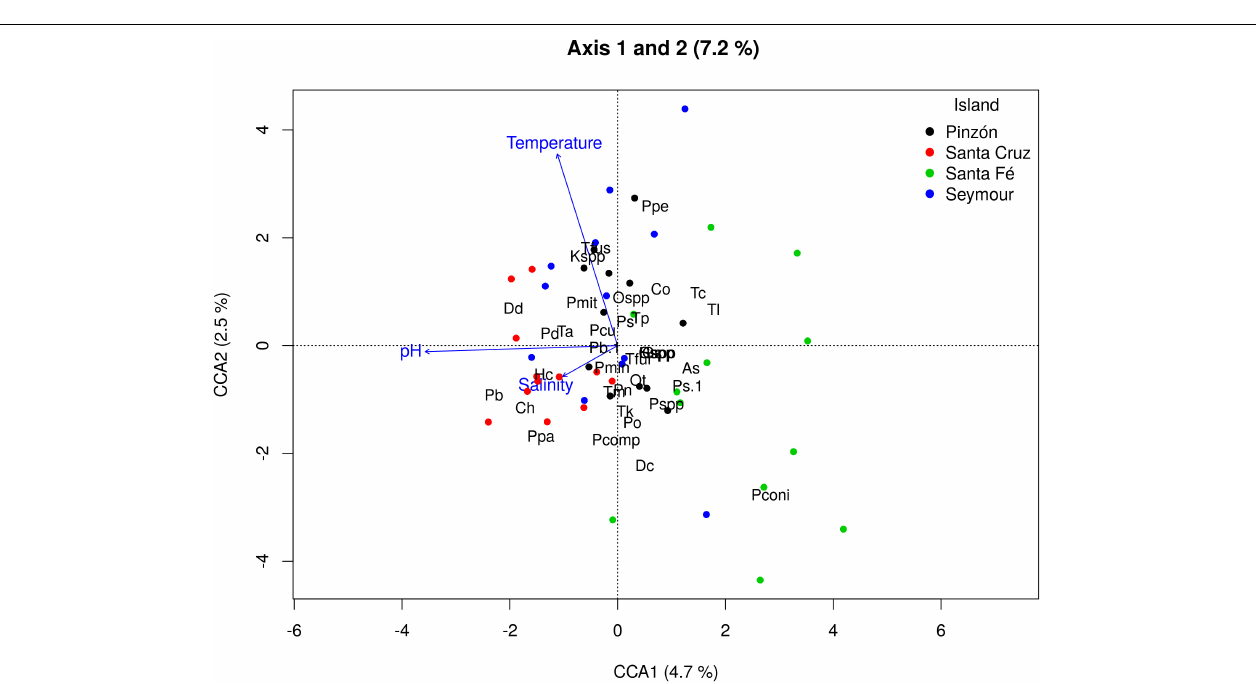
FIGURE 4 | Canonical correspondence analysis triplot. Sampling stations shown as colored dots according to each Island. The species present in the community follows: Dd , Dinophysis doryphora , Kspp , Karlodinium spp., Pconi , Protoperidinium conicum , Ppe , Protoperidinium pellucidum ; Dc , Dinophysis caudata ; Ospp